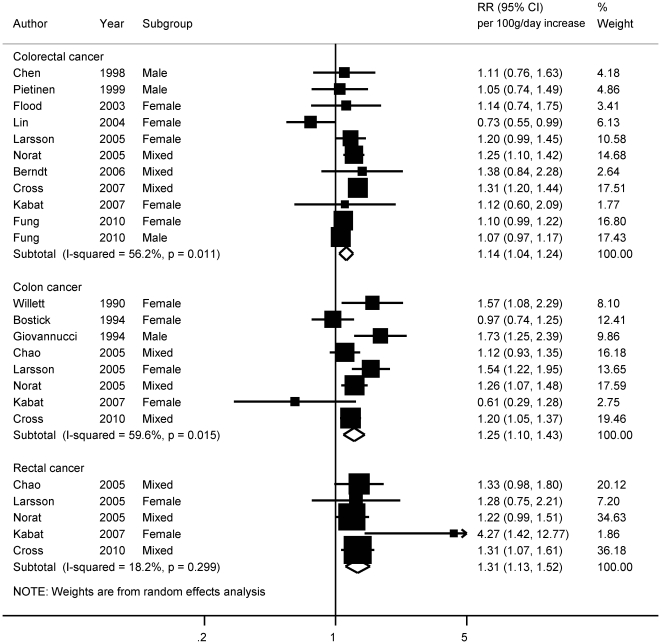
Dose-response meta-analyses of total red and processed meats consumption and the risk of colorectal, colon and rectal cancers.References: Chen, 1998 [51]; Pietinen, 1999 [57]; Flood, 2003 [33]; Lin, 2004 [56]; Larsson, 2005 [34]; Norat, 2005 [50]; Berndt, 2006 [19]; Cross, 2007 [22]; Kabat, 2007 [24]; Fung, 2010 [23]; Willett, 1990 [58]; Bostick, 1994 [52]; Giovannuccci, 1994 [55]; Chao, 2005 [54]; Cross, 2010 [21].